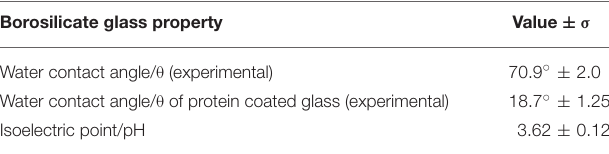
TABLE 1 | Contact angle measured for ultrapure water on uncoated borosilicate glass substrate and on a protein coated borosilicate glass ( n = 3) are given accompanied with the standard error ( σ